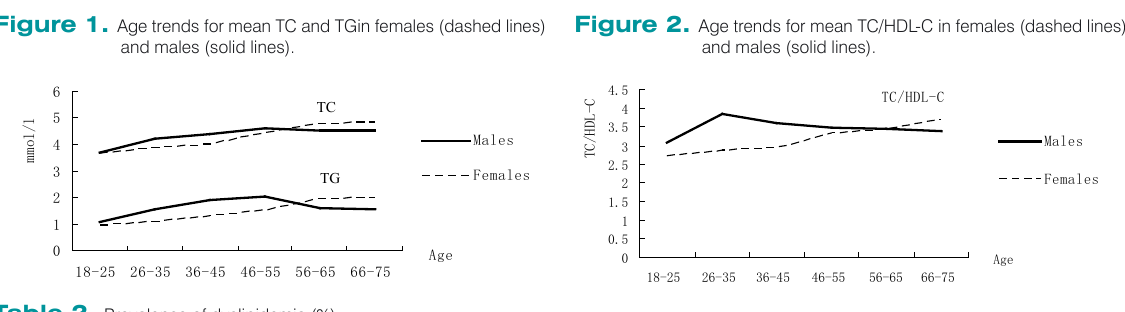
Figure 2.Age trends for mean TC/HDL-C in females(dashed lines)and males(solid lines).